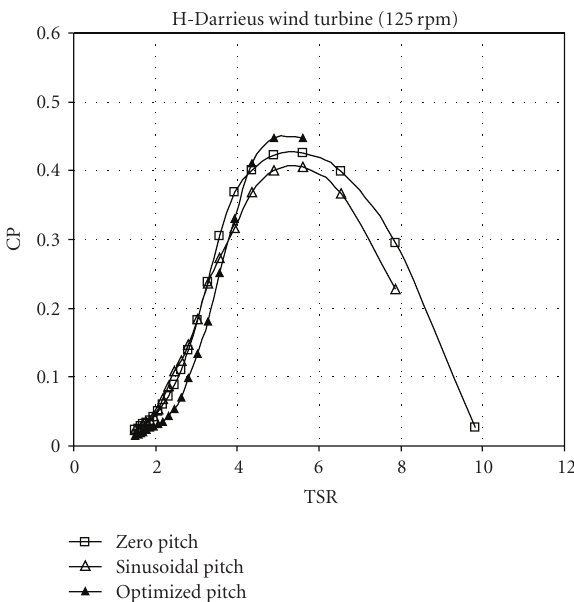
Figure 6: Power coe ffi cient versus TSR for the 7kW VAWT with fixed and optimized variable pitch.